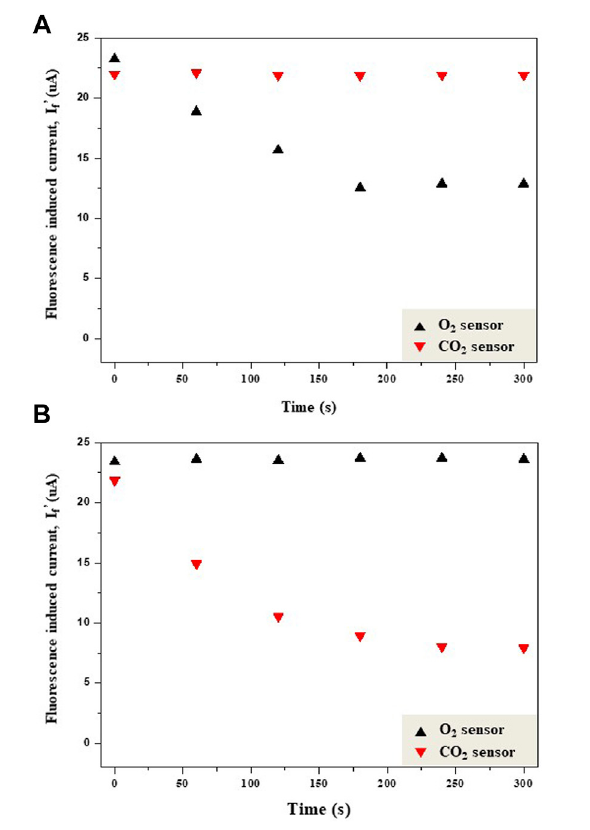
FIGURE 11 | (A) Responses of the O 2 sensors under different temperatures, and (B) responses of the CO 2 sensors under different temperatures.